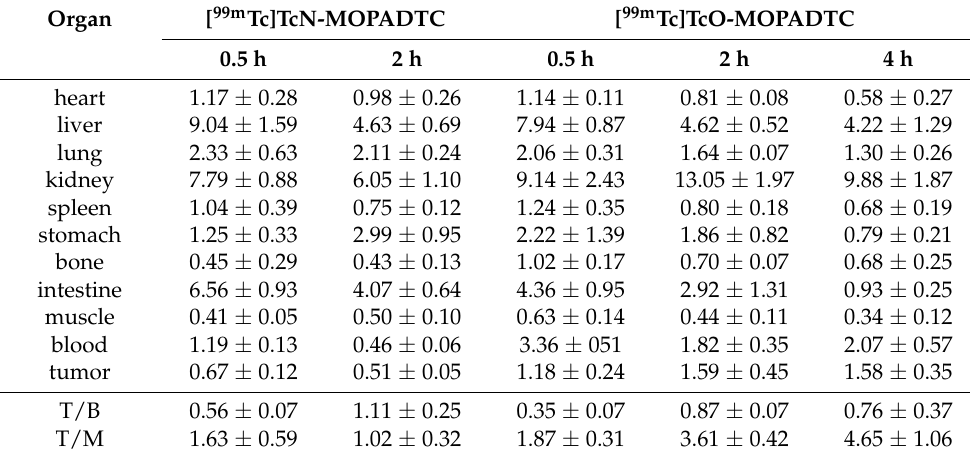
Table 1. Results of biodistribution of [ 99m Tc]TcN-MOPADTC and [ 99m Tc]TcO-MOPADTC (%ID/g ± SD, n = 5, T/B = tumor/blood ratio, T/M = tumor/muscle